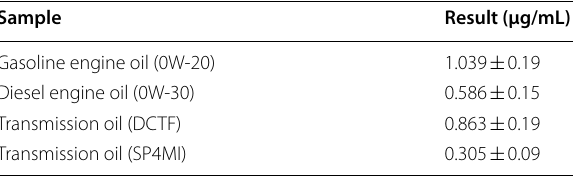
Table 2 Results of the analyses of the actual